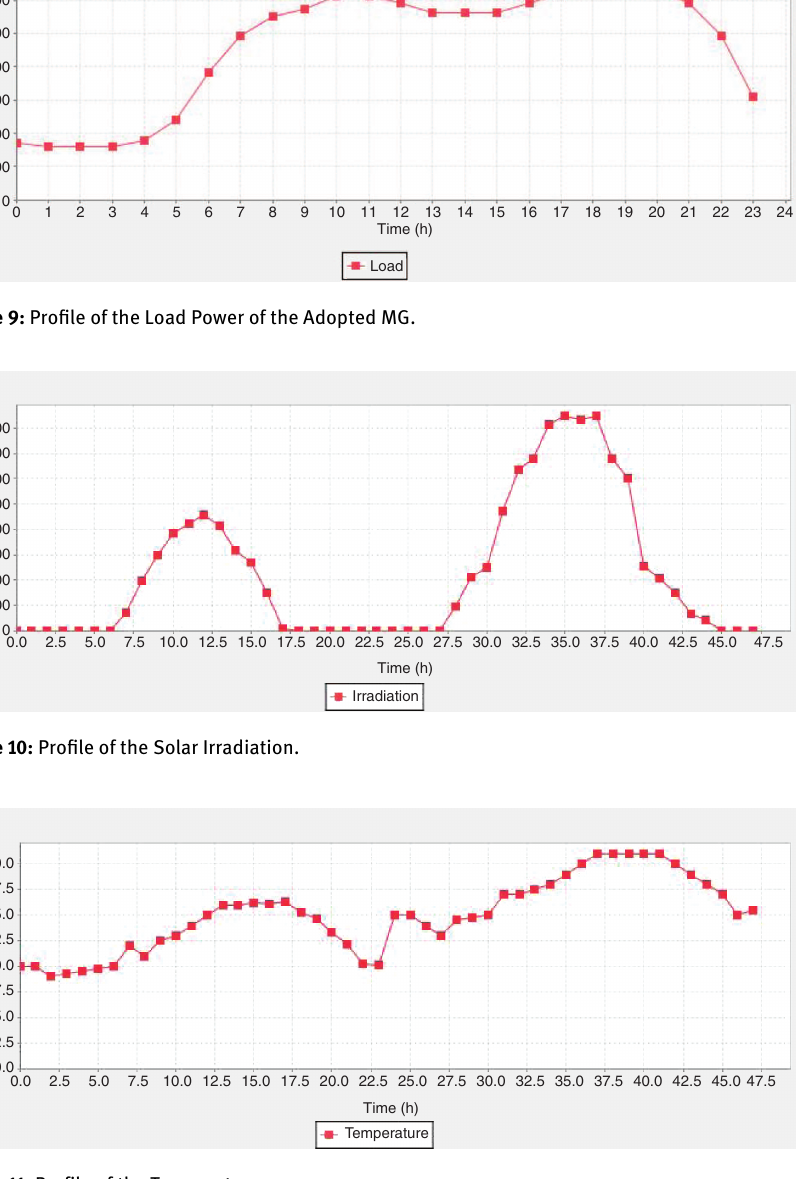
Figure 11: Profile of the